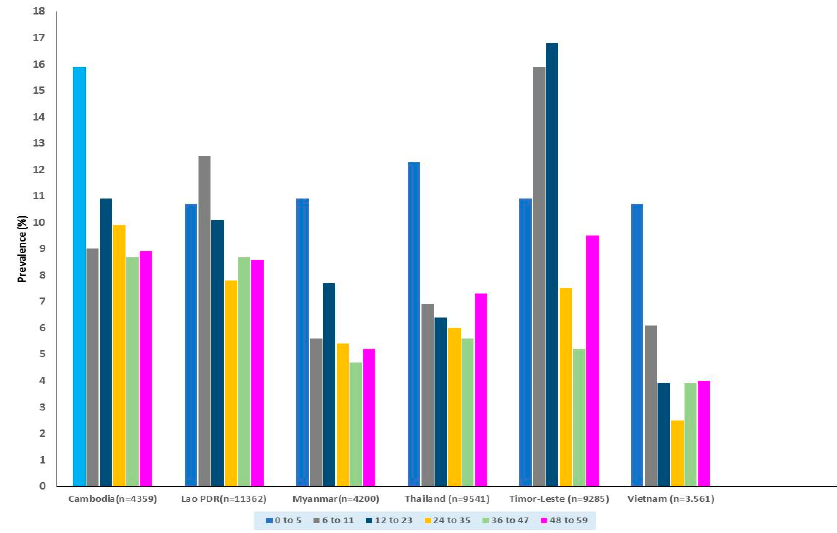
Figure 1. Prevalence of wasting in the different age groups by country.